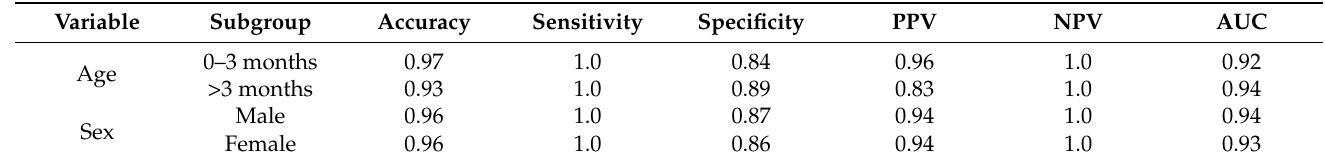
Table 3. Comparison of accuracy, sensitivity, specificity, PPV, NPV and AUC in subgroups of data categorized based on age and sex. Note that there was no systematic bias in any subgroup.